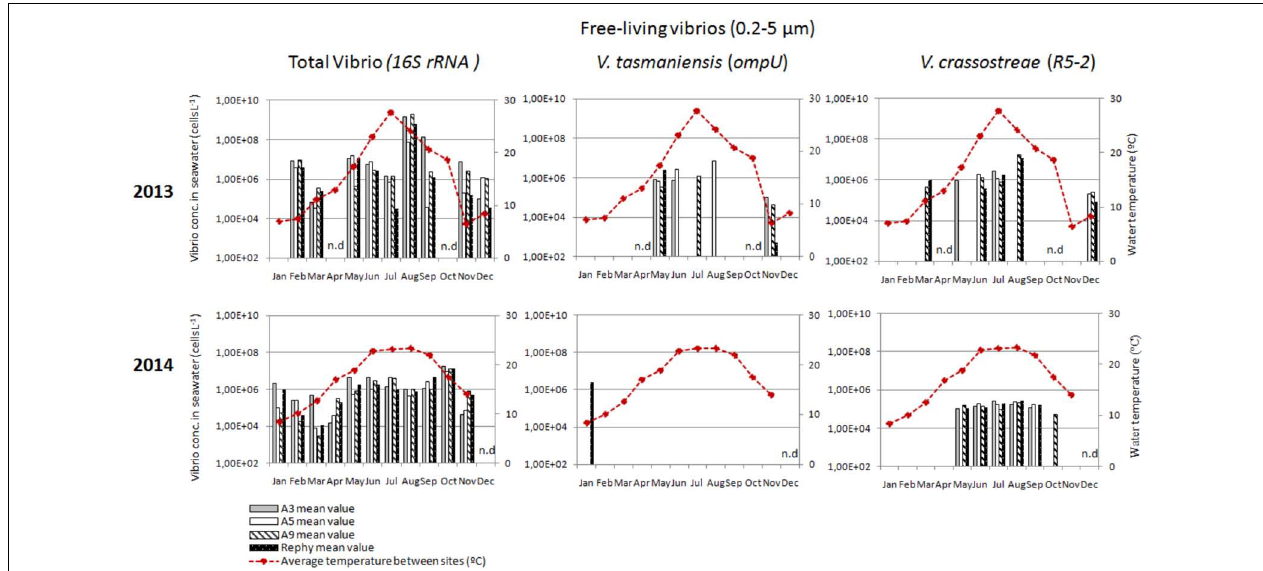
FIGURE 2 | Monthly abundance of free-living vibrios in the water column. Histograms show apparent vibrio concentrations based on qPCR amplification ( 16S rRNA , ompU , and R5-2 ) of DNA extracted from the 0.2–5 µ m fraction of the water column. Samples were collected outside the oyster culture area (A3, gray bars and A5, white bars ) and inside an oyster farm (A9, hatched white bars and Rephy, hatched black bars ). Mean seawater temperature ( ◦ C) is represented by a red line. n.d., not determined.